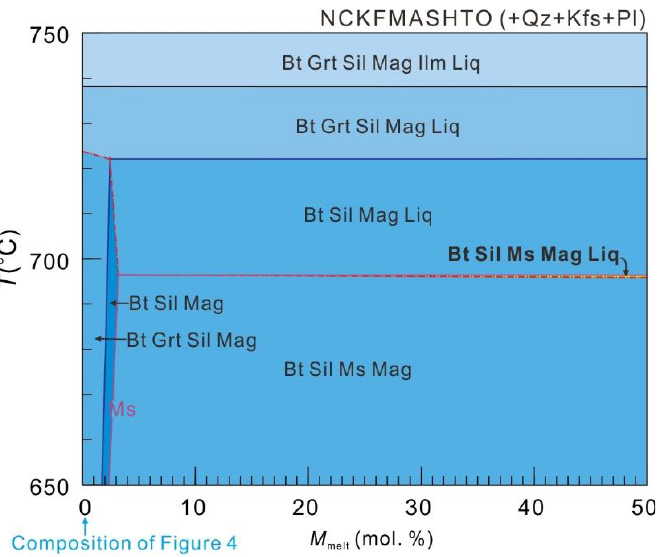
Figure 5. T–M (melt) diagram at 6 kbar. The melt composition was calculated at 6 kbar on the solidus of Figure 4, and the composition at M (melt) = 0 equals to the composition for Figure 4.